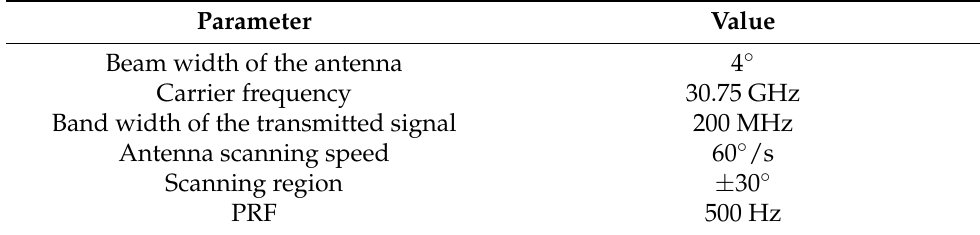
Table 3. Parameters of the